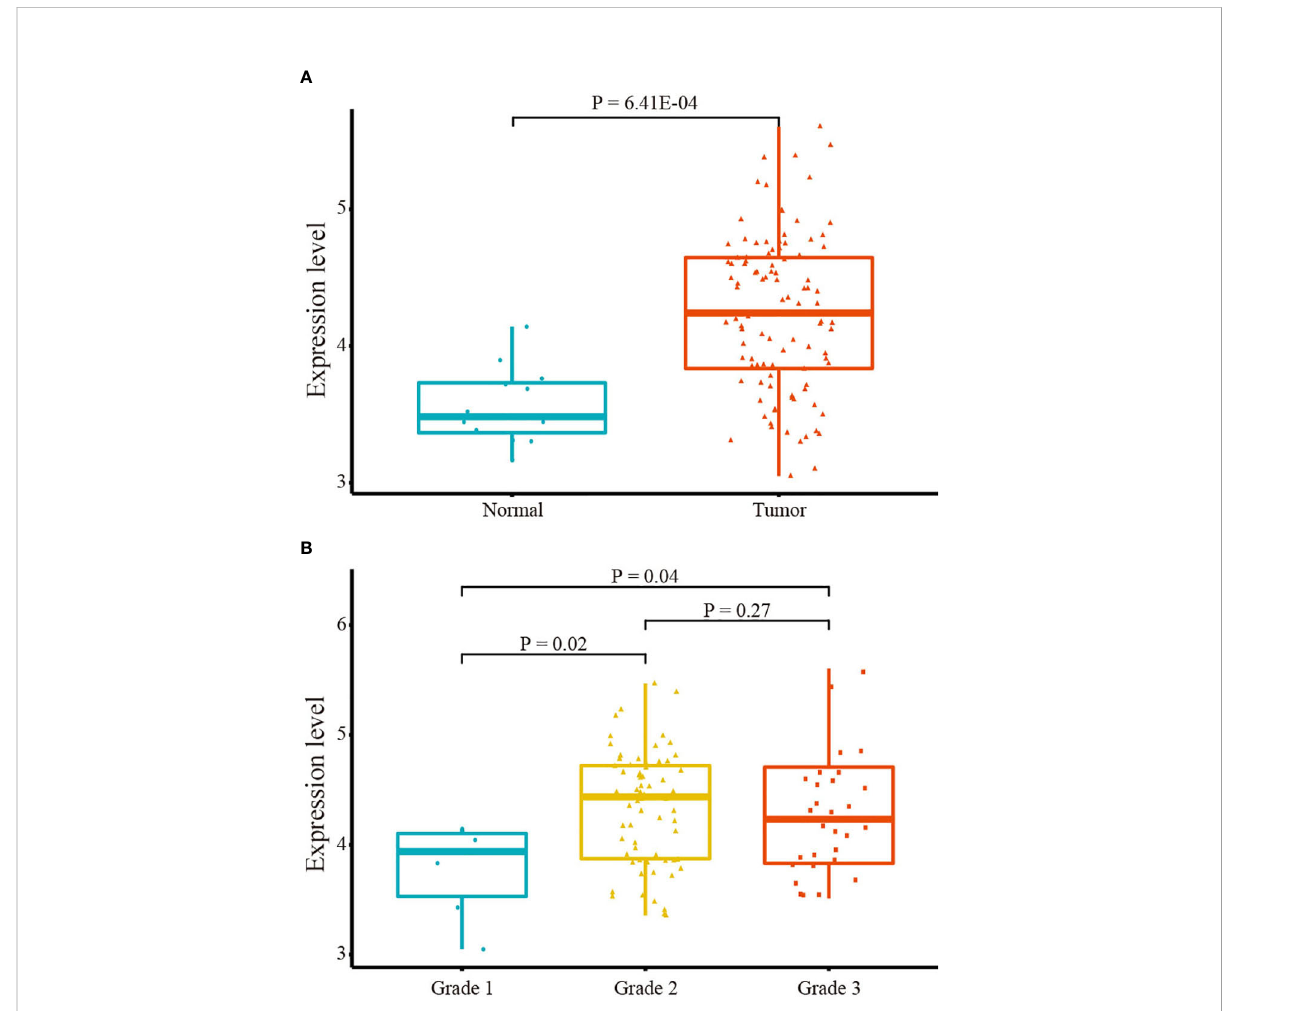
FIGURE 2 IGF2R mRNA expression. (A) IGF2R expression in tumor and normal tissues. (B) IGF2R expression across clinical